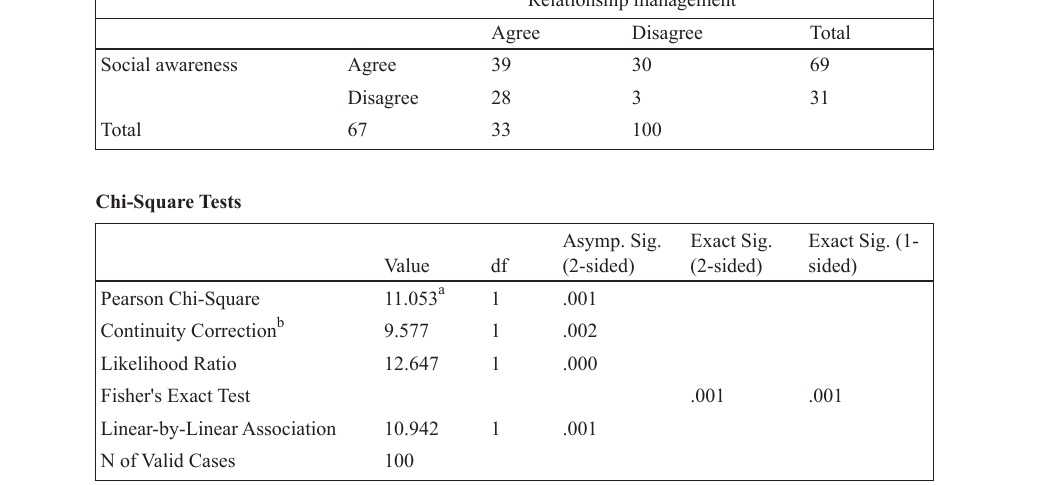
Relationship management